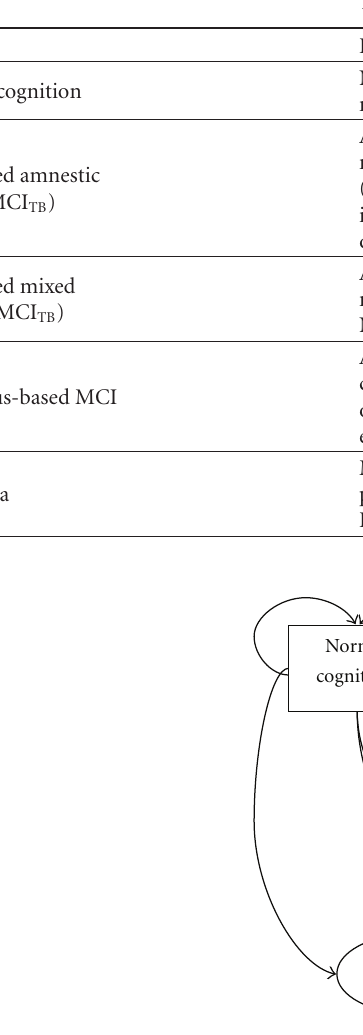
Figure 1: Flow diagram of transitions possible between subject visits. Normal cognition is the base state for transitions made from normal cognition, test-based amnestic MCI, and test-based mixed MCI; clinical consensus MCI is the base state